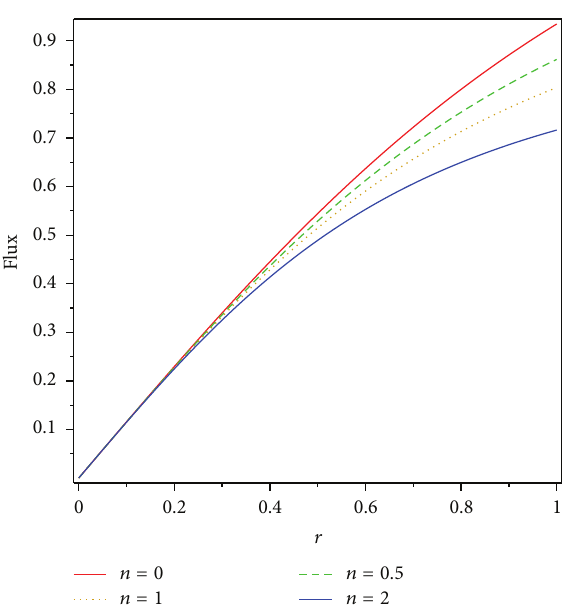
Figure 9: Heat flux for varying values of 𝑛